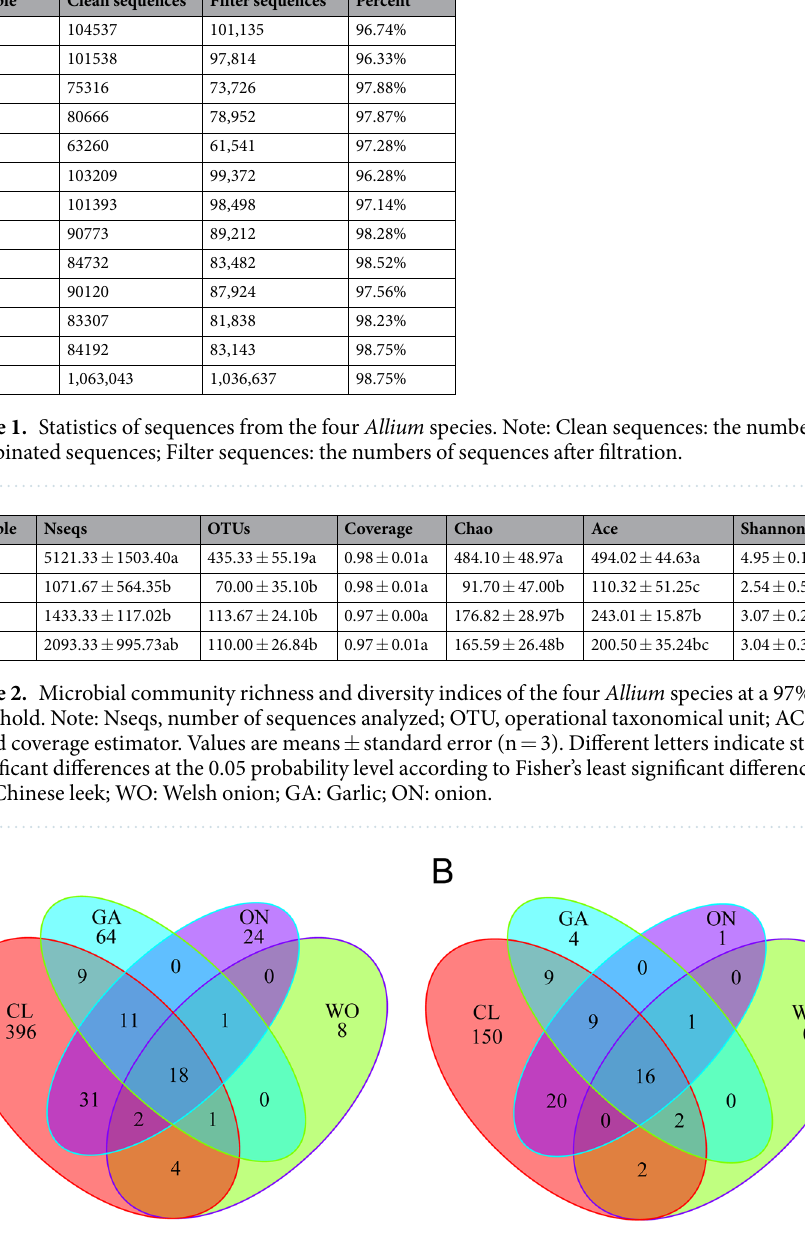
Figure 1. Venn diagrams of the endophytic bacteria of the four Allium species. The OTUs ( A ) and bacterial genera ( B ) shared between Allium species. CL: Chinese leek; WO: Welsh onion; GA: Garlic; ON: